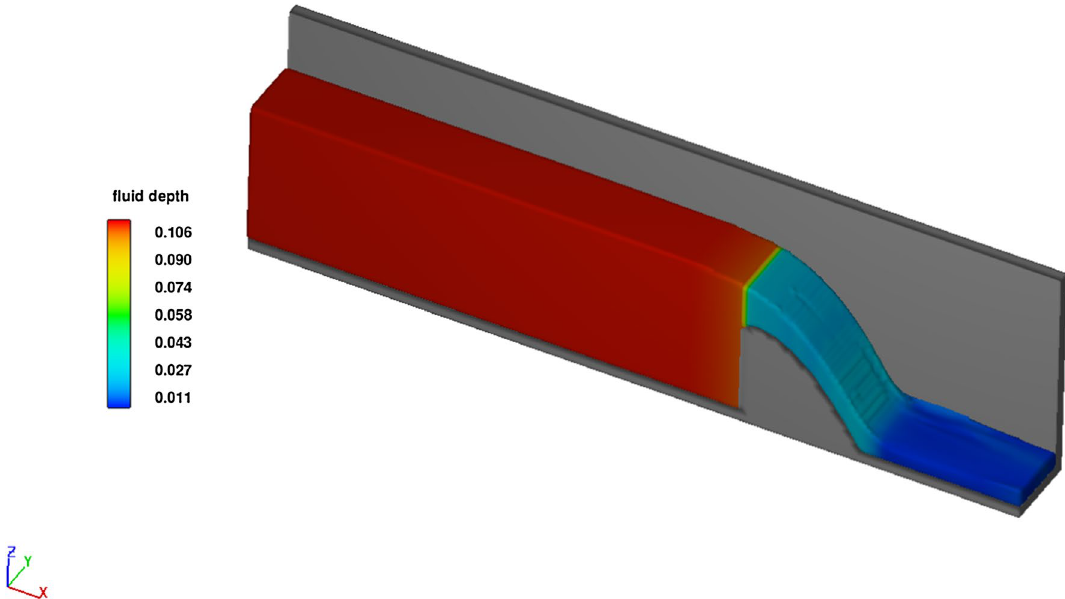
Fig. 15 Numerical modeling Table 2 Results obtained from numerical and physical